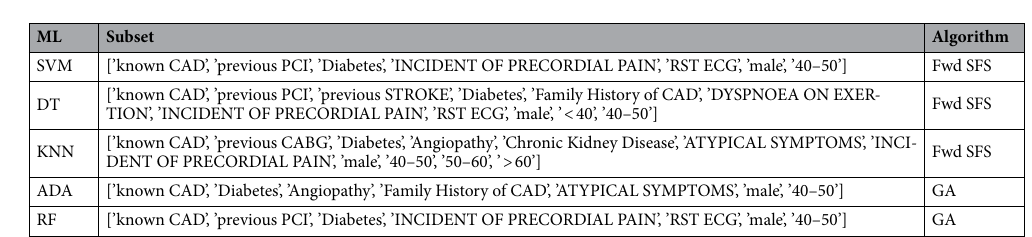
Table 8. Best Performing Feature Subsets for each ML model and their Selection algorithm (without expert’s verdict).